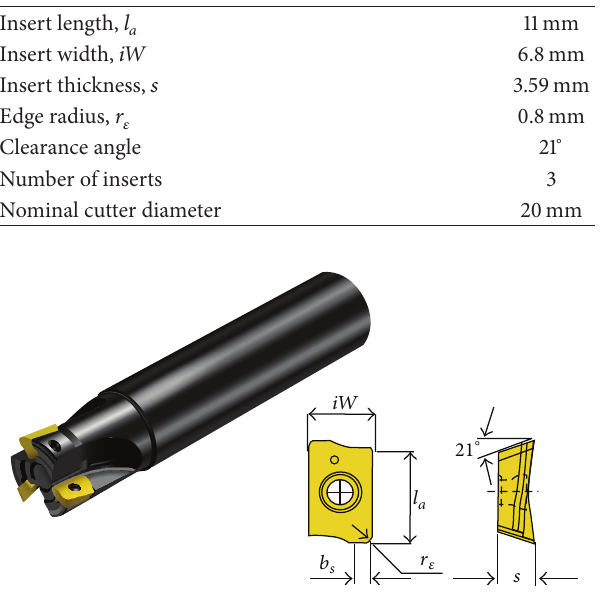
Table 1: Insert and end mill geometry.